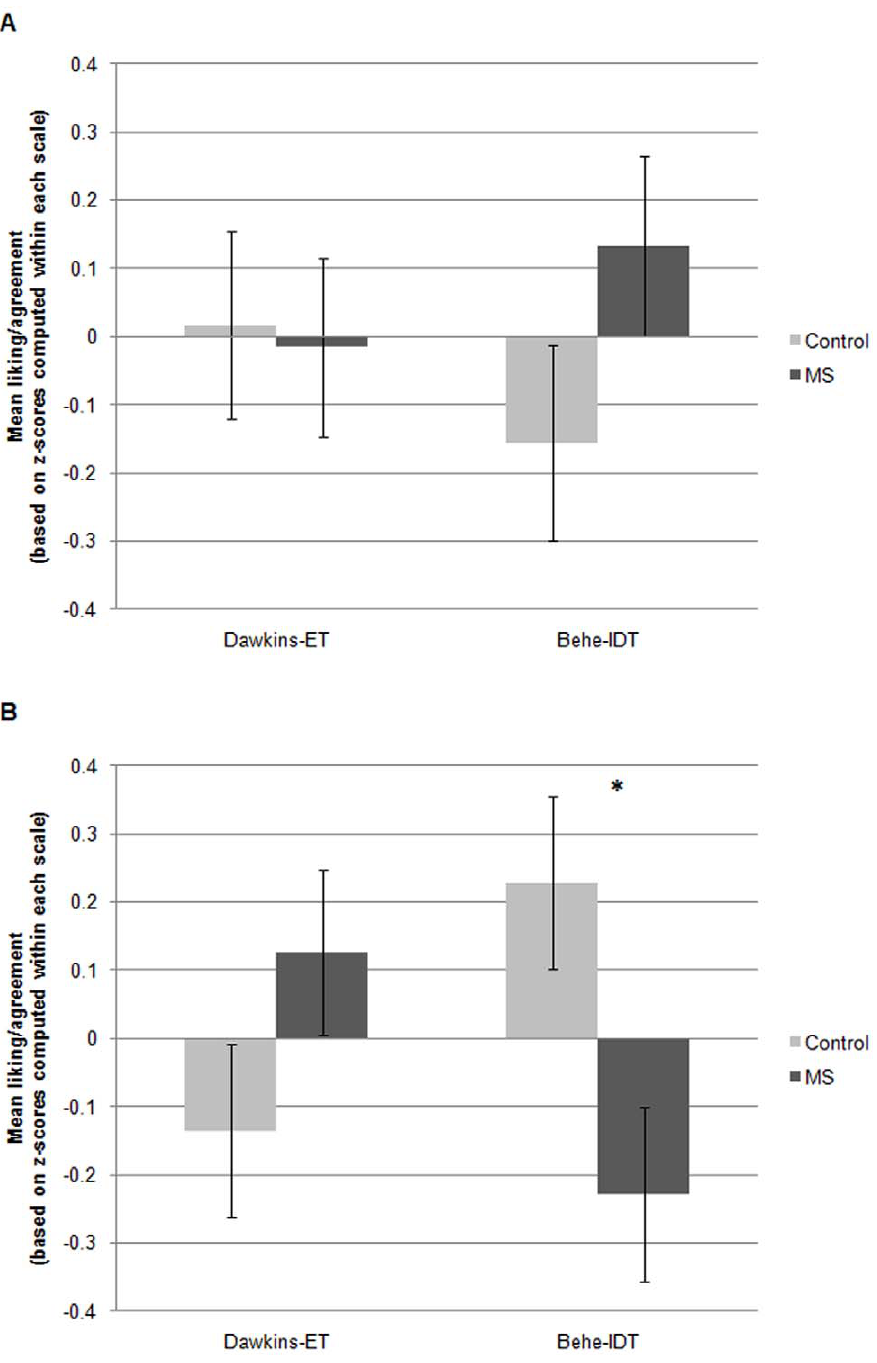
Figure 4. Effects of MS on liking of Behe and belief in IDT, and liking of Dawkins and belief in ET, for participants who did not read Sagan’s excerpt about naturalism (Panel A) and those who did (Panel B), Study 4. Note. Values are based on standard scores; means for each scale were computed by standardizing each of the six author-theory items that the scale comprised, around their common mean, and taking the mean of the resulting z-scores. Because the two scales were centered around different means, values on the two scales (Dawkins-ET and Behe-IDT) cannot be directly compared to each other. The overall three-way interaction, based on a between-subjects ANOVA, and, in Panel B, the two-way interaction and the difference between the control and MS conditions, based on a between-subjects ANOVA and a t -test on Behe-IDT, respectively, were significant, p s , .05. Error bars represent the standard error of the mean. * p , .05. doi:10.1371/journal.pone.0017349.g004 Sagan condition, F (1, 47) =6.20, p , .05. There was also an of stable religious views, F (1, 83)= 8.32, and acceptance of evolution, F (1, 91)= 8.74; p s , .05. As in the full sample, a two- interaction in the no-Sagan condition, F (1, 45)= 3.18, p , .05 one- way interaction between MS and author-theory emerged in the tailed. In both no-Sagan and Sagan conditions, simple effects